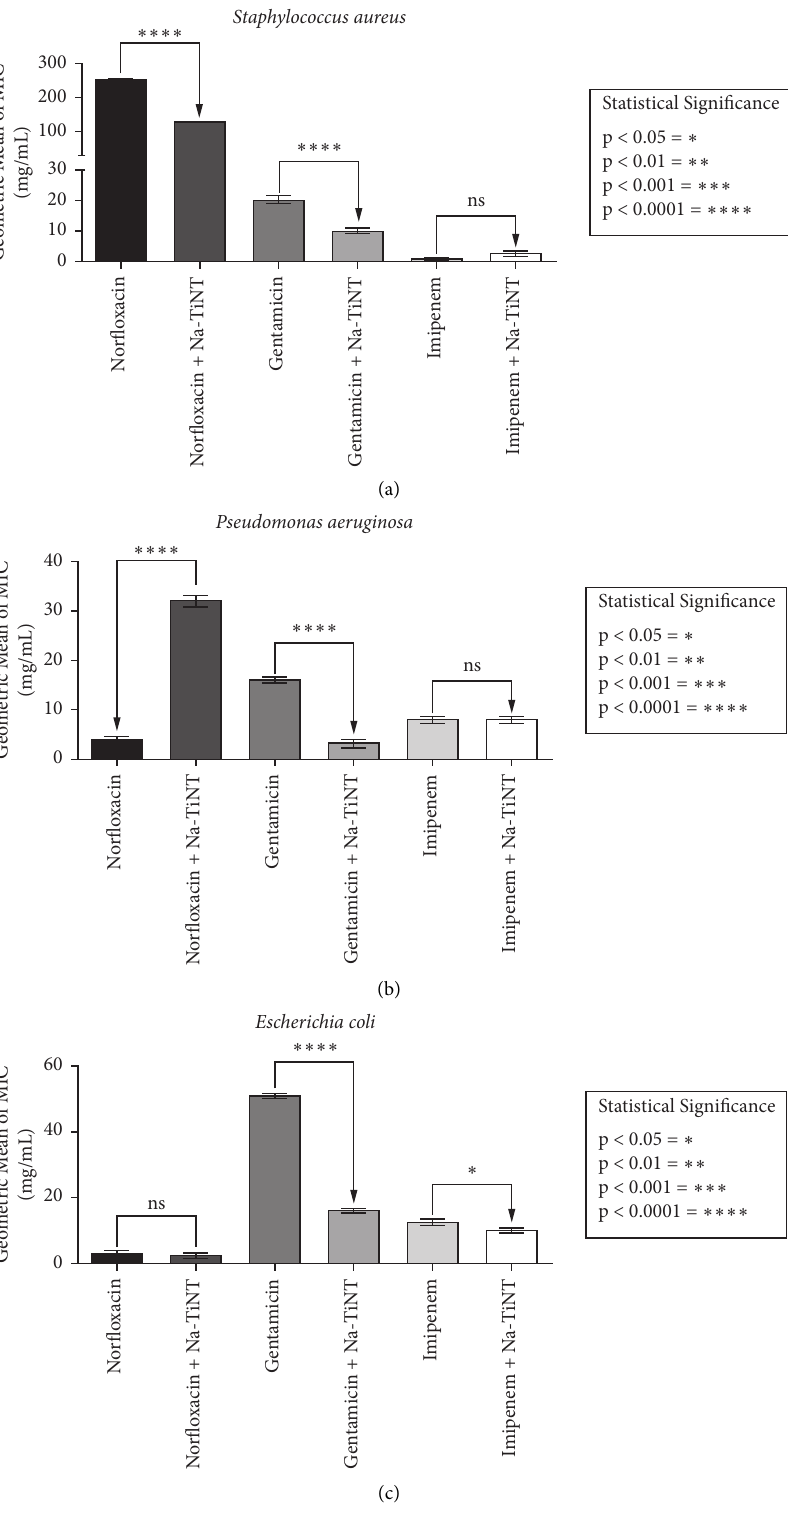
Figure 5: Antibiotic action of sodium titanate (Na-TiNT) in combination with different antibiotics, norfloxacin, gentamicin, and imipenem, compared to the effect of these antibiotics isolated on Staphylococcus aureus (a), Pseudomonas aeruginosa (b), and Escherichia coli (c). The numbers of ( ∗ ) express the level of significance between treatment and